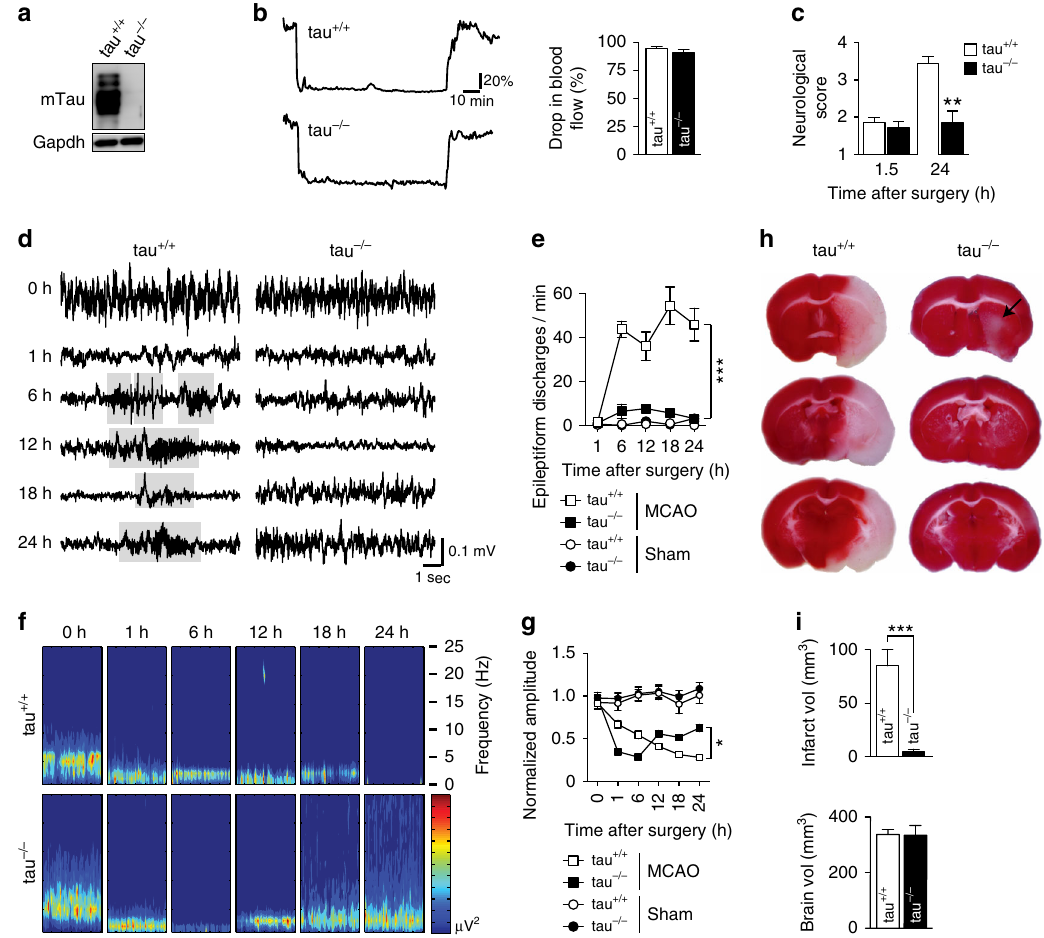
Fig. 1 Tau − / − mice are protected from neurological de fi cits, aberrant hyperexcitation and extensive brain damage after transient MCAO. a Western blotting for murine tau (mTau) in brain extracts from tau +/+ and tau − / − mice. GAPDH con fi rmed equal loading. b Ischemic stroke was induced by middle cerebral artery occlusion (MCAO) for 1.5 h with subsequent reperfusion. Drop in blood fl ow in the MCA was the same in tau − / − and tau +/+ mice during MCAO, as determined by laser Doppler fl owmetry (not signi fi cant; N = 12; Student ’ s t -test). Unit, % of baseline fl ow. c Neurological scoring (with higher numbers indicating more severe impairments) revealed similar de fi cits directly after MCAO in tau − / − and tau +/+ mice. Only tau +/+ mice showed a worsening of de fi cits at 24 h (** P < 0.01; N = 12; 2-way ANOVA (Sidak post hoc)). d Representative electroencephalography (EEG) recordings in tau − / − and tau +/+ mice at baseline (0 h) and indicated times after transient MCAO. Suppressed EEG signals recovered after 12 h following MCAO in tau − / − mice, while tau +/+ mice presented with epileptiform discharges ( gray boxed ) after 6 h. e Quanti fi cation revealed persistently high numbers of epileptiform discharges 6 h after transient MCAO (*** p < 0.001 vs. tau − / − MCAO; N = 5; two-way ANOVA (Bonferroni post hoc)). A small increase in epileptiform spike trains was transient in tau − / − mice, and reached levels of sham operated tau − / − and tau +/+ mice 24 h after transient MCAO. f EEG frequency power spectrum (0 – 25 Hz) tau +/+ and tau − / − mice at baseline (0 h) indicated times following transient MCAO, with recovery only in tau − / − animals. g Quanti fi cation of EEG recordings showed a progressive amplitude decline in tau +/+ mice that partial recovered tau − / − animals (* p < 0.05; N = 5; two-way ANOVA (Bonferroni post hoc)). h TTC-stained serial brain sections of tau +/+ and tau − / − mice 24 h after MCAO (viable tissue stains red ). Note the large infarcted area ( white ) in tau +/+ , while only minimal brain damage was present in tau − / − mice ( arrow ). i Volumetric quanti fi cation of infarct and brain volumes in tau +/+ and tau − / − mice 24 h after transient MCAO (*** p < 0.001; N = 12; Student ’ s t -test). All error bars are